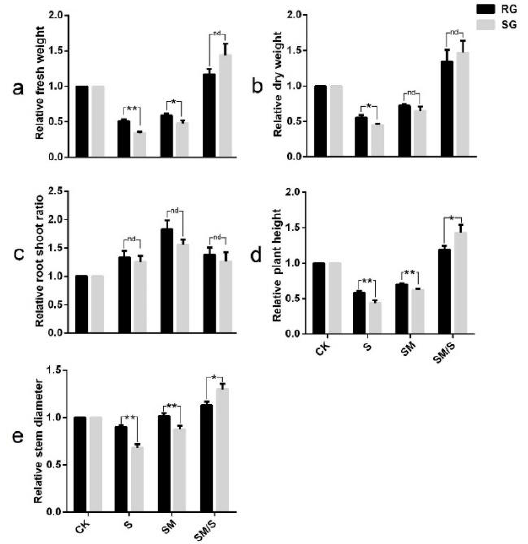
Figure 1. Comparison of the growth indexes including relative fresh weight ( a ), relative dry weight ( b ), relative root shoot ratio ( c ), relative plant height ( d ), and relative stem diameter ( e ) between salt-resistant and salt sensitive tomato seedlings under salt stress. All the indices were normalized to CK. RG: salt-resistant genotype; SG: salt-sensitive genotype; CK: 1/2 garden nutrient solution of Japan (GNSJ) + spraying distilled water; M: GNSJ + spraying 100 µ M melatonin; S: GNSJ-NaCl (containing 200 mM NaCl) + spraying distilled water; SM: GNSJ-NaCl (containing 200 mM NaCl) + spraying 100 µ M melatonin. The asterisk indicates significant difference detected by Student’s t -test ( p < 0.05 marked with * and p < 0.01 marked with **). nd: no difference. Mean ± SE were given (n = 5, biological replications).